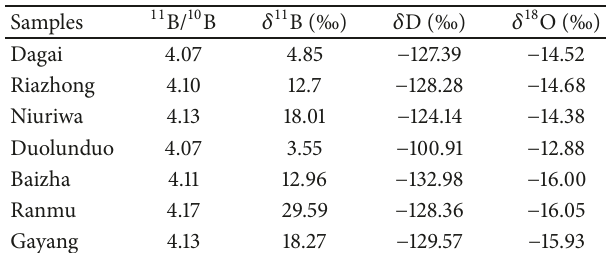
Table 3: B, H, and O isotopes for the saline springs, Nangqen Basin, June 2014.